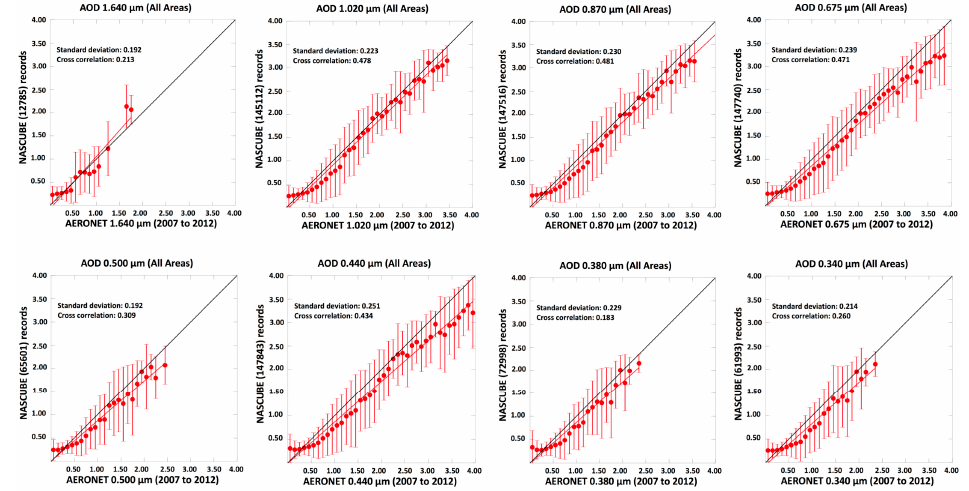
Figure 9. Operational neural AOD retrieval model. The mean (dots) and standard deviation of the NASCube AOD retrievals versus the input AERONET measurements for AOD value split in classes of 0.1 for all wavelengths, for values covering 2007 to 2012.